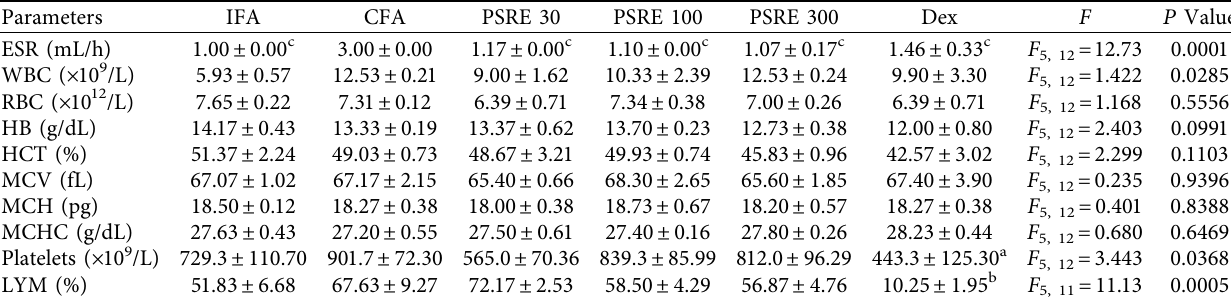
Figure 4: Effect of PSRE and dexamethasone on radiographic scores (a) and TGF-beta1 levels (b) in rats in the therapeutic protocol of adjuvant-induced arthritis. Values are the mean ± SEM. ( n � 5–6). ∗∗ P < 0 . 01, ∗∗∗ P < 0 . 001, ∗∗∗∗ P < 0 . 0001 compared to CFA group (One- way ANOVA analysis followed by Tukey’s multiple comparison test). Table 1: Hematological analysis of arthritic rats in the therapeutic study.